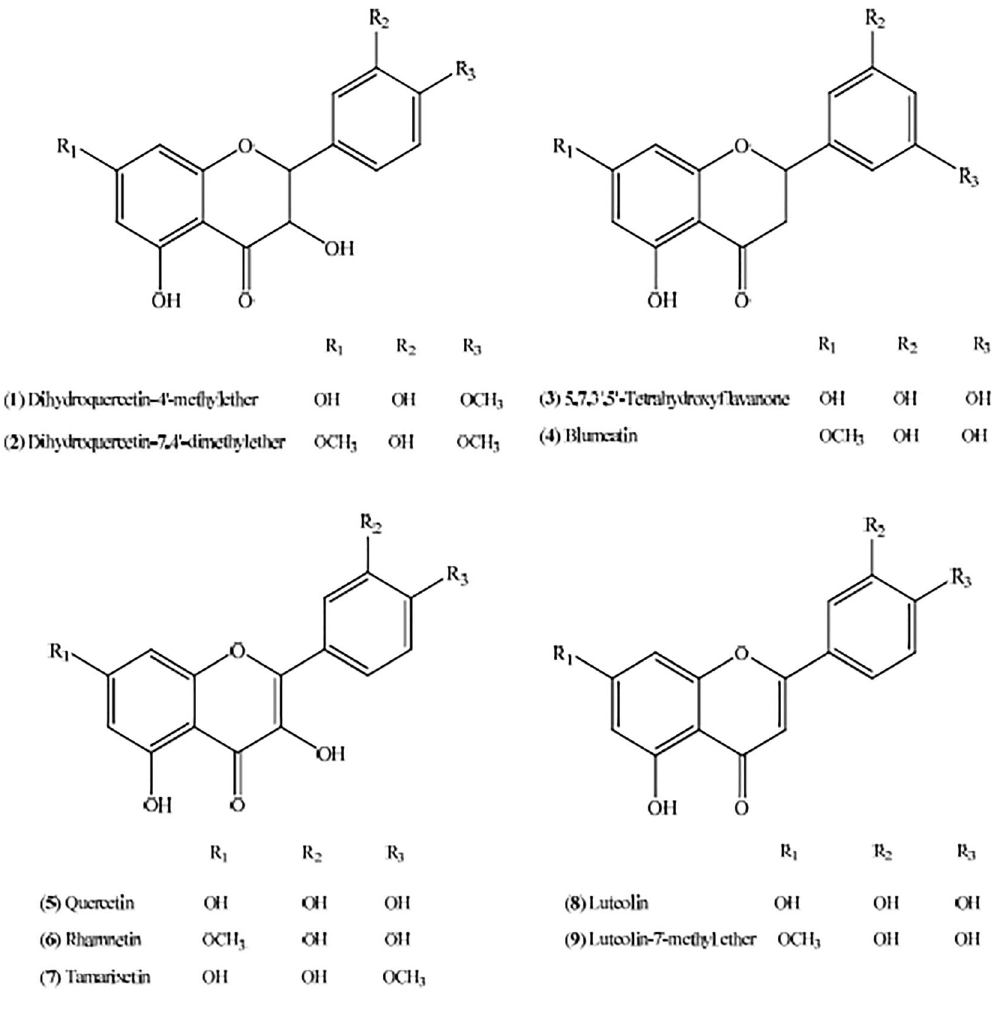
Figure 2. Molecular graphs of isolated flavonoids, Source 1